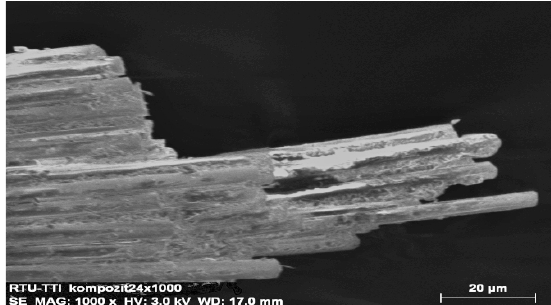
Fig. 8. A fragment of the destroyed portion of the composite